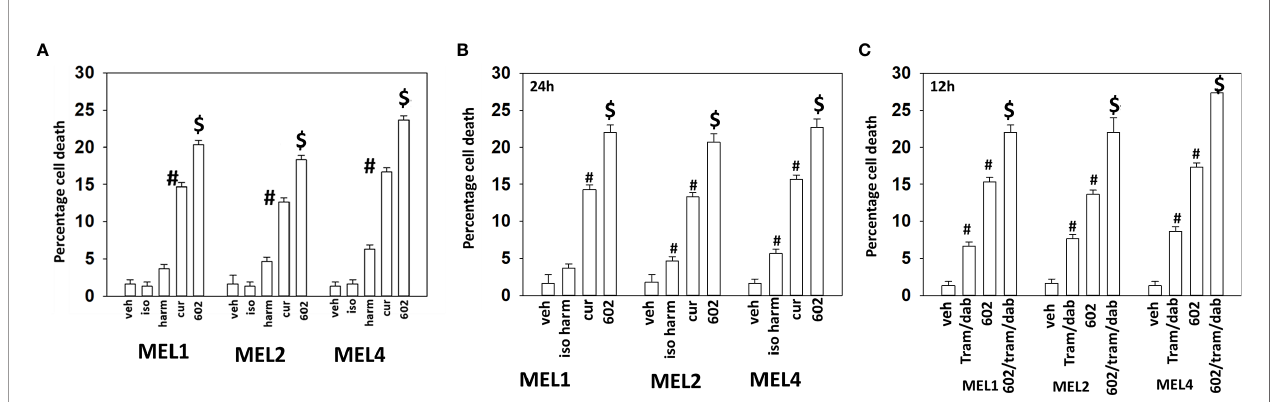
FIGURE 1 | GZ17-6.02 interacts with [trametinib + dabrafenib] to kill cutaneous melanoma cells expressing B-RAF V600E. (A) Melanoma cells were treated with vehicle control, isovanillin (37.2 µM), harmine (4.5 µM), curcumin (2 µM) or GZ17-6.02 [curcumin (2 µM) + isovanillin (37.2 µM) + harmine (4.5 µM)] for 24h. Cells were isolated and viability determined by trypan blue exclusion (n = 3 +/- SD). # p < 0.05 greater than vehicle control; $ p < 0.05 greater than value in cells treated with curcumin alone. (B) Melanoma cells were treated with vehicle control, [isovanillin (37.2 µM) + harmine (4.5 µM)], curcumin (2 µM) or GZ17-6.02 [curcumin (2 µM) + isovanillin (37.2 µM) + harmine (4.5 µM)] for 24h. Cells were isolated and viability determined by trypan blue exclusion (n = 3 +/- SD). # p < 0.05 greater than vehicle control; $ p < 0.05 greater than value in cells treated with curcumin alone. (C) Melanoma cells were treated with vehicle control, GZ17-6.02 [curcumin (2 µM) + isovanillin (37.2 µM) + harmine (4.5 µM)], [trametinib (Tram, 2 µM) + dabrafenib (dab, 2 µM)] or the drugs in combination for 12h. Cells were isolated and viability determined by trypan blue exclusion (n = 3 +/- SD). # p < 0.05 greater than vehicle control; $ p < 0.05 greater than value in cells treated with GZ17-6.02